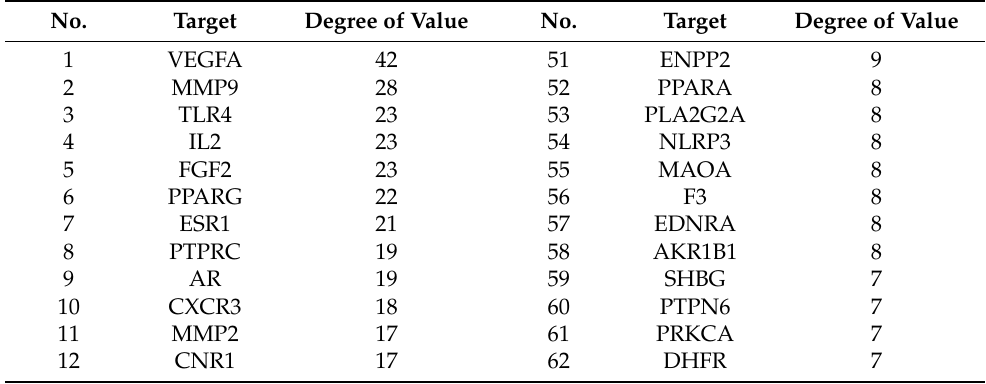
Table 3. The degree value of target in